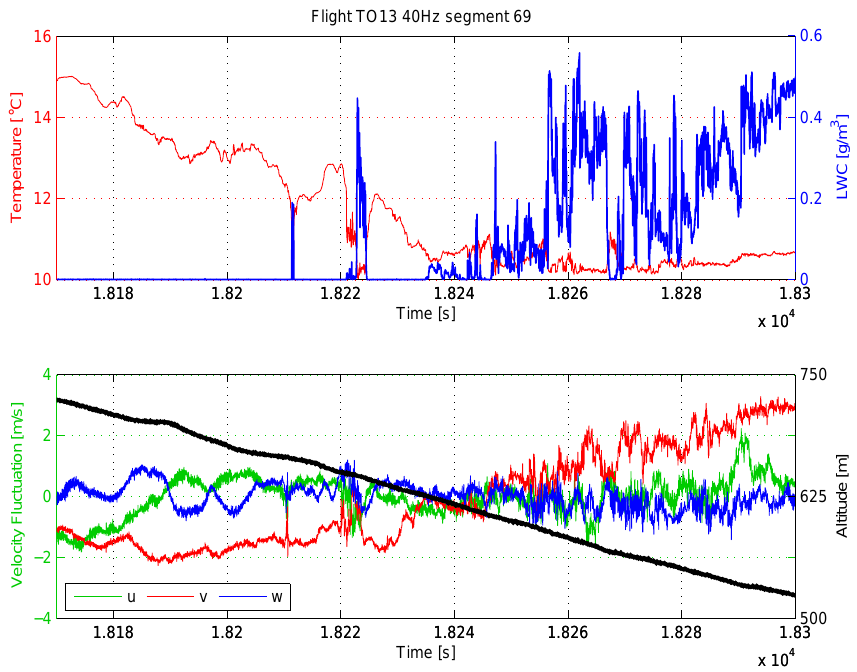
Fig. 5. As in Fig. 4, but for flight TO13.